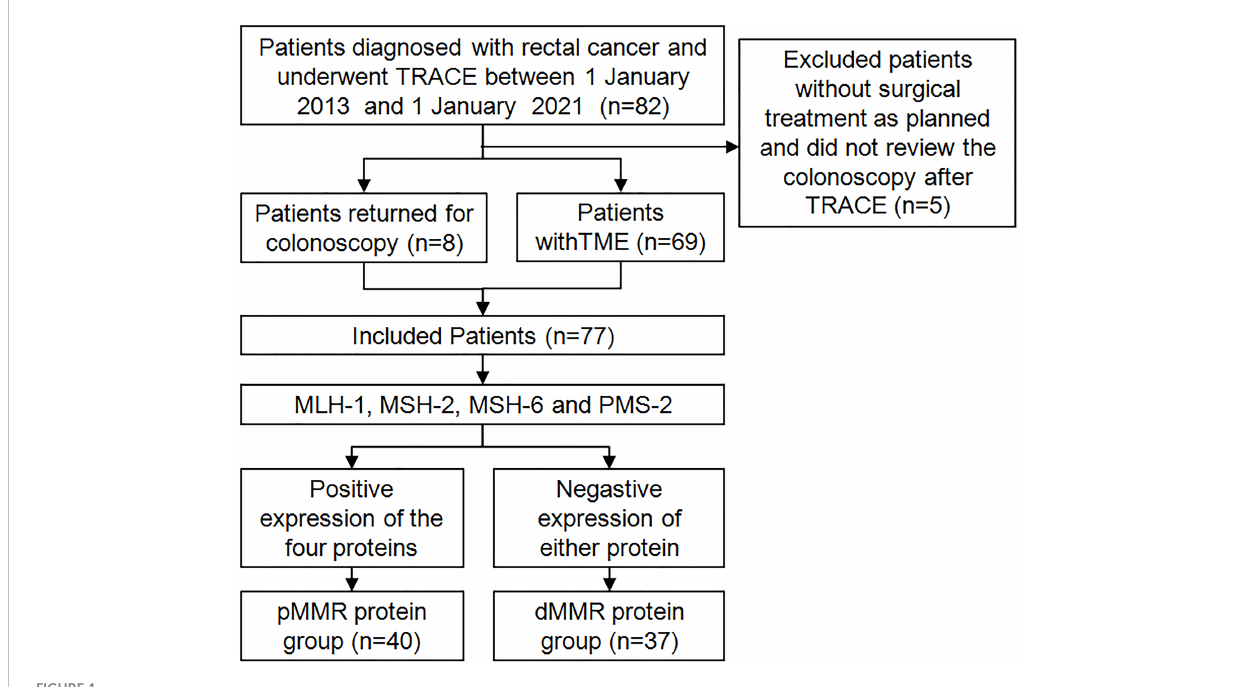
FIGURE 1 The patients ’ recruitment and study design.